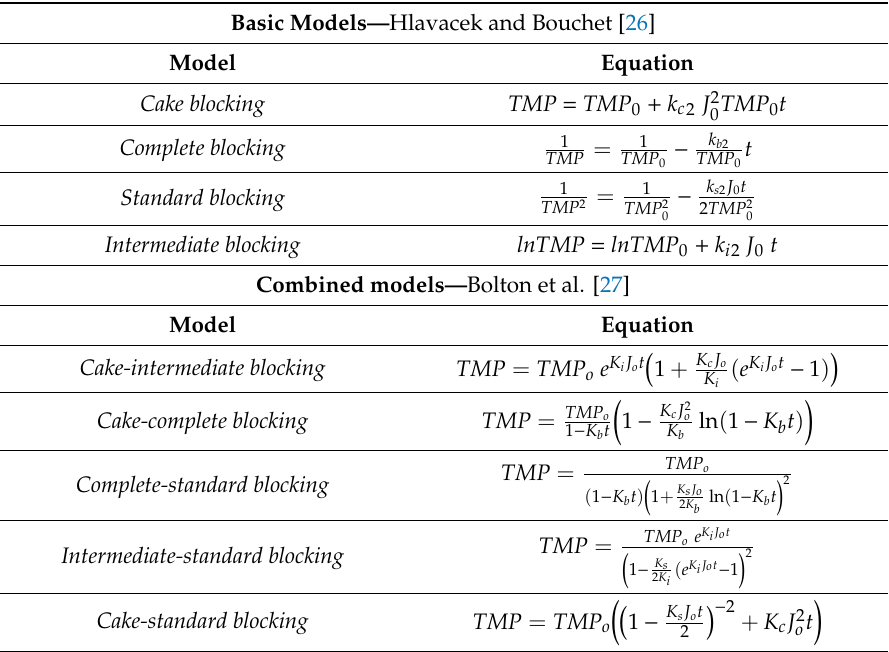
Table 2. Basic and combined models for membrane fouling description. Basic Models— Hlavacek and Bouchet